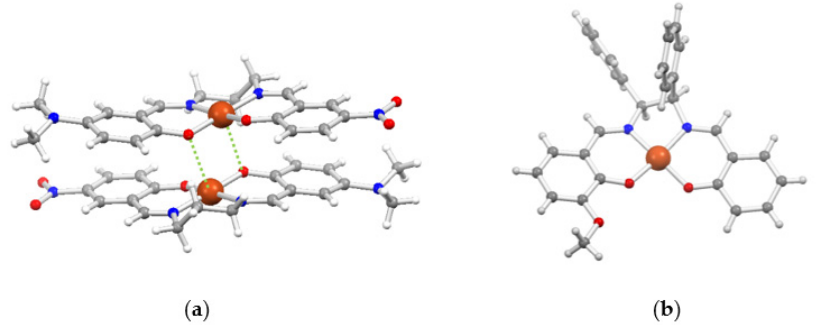
Figure 5. Molecular structures of the unsymmetrically substituted copper(II) complexes ( a ) [Cu(5- NO 2 -5 (cid:48) -NMe 2 -saltn] (shown as head-to-tail dimer with short Cu ··· O(phenoxido) apical contacts as dashed green lines), CSD/CCDC NEXGED/608124 [63], and ( b ) [Cu(3-OMe-sal(1 S ,2 R )dpen], CSD/CCDC ADIMEI/1041832 [70]. Reproduction of the structures with Mercury ® 4.3.1 software [71], color code: Cu = orange, O = red, N = blue, C = gray, H = white.